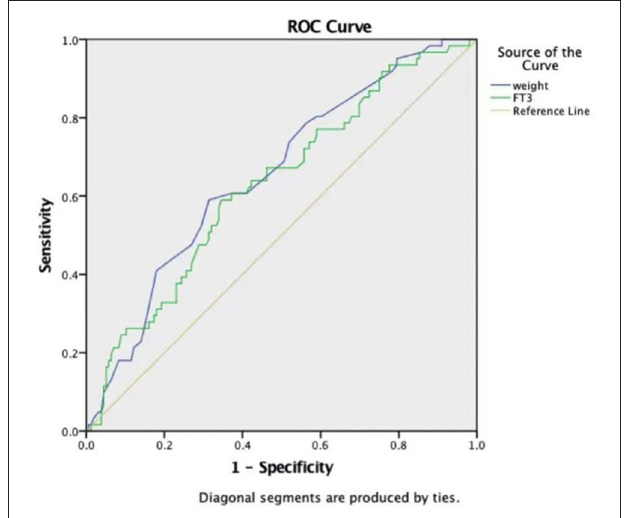
FIGURE 2 | Receiver operating characteristic curves of weight and free triiodothyronine